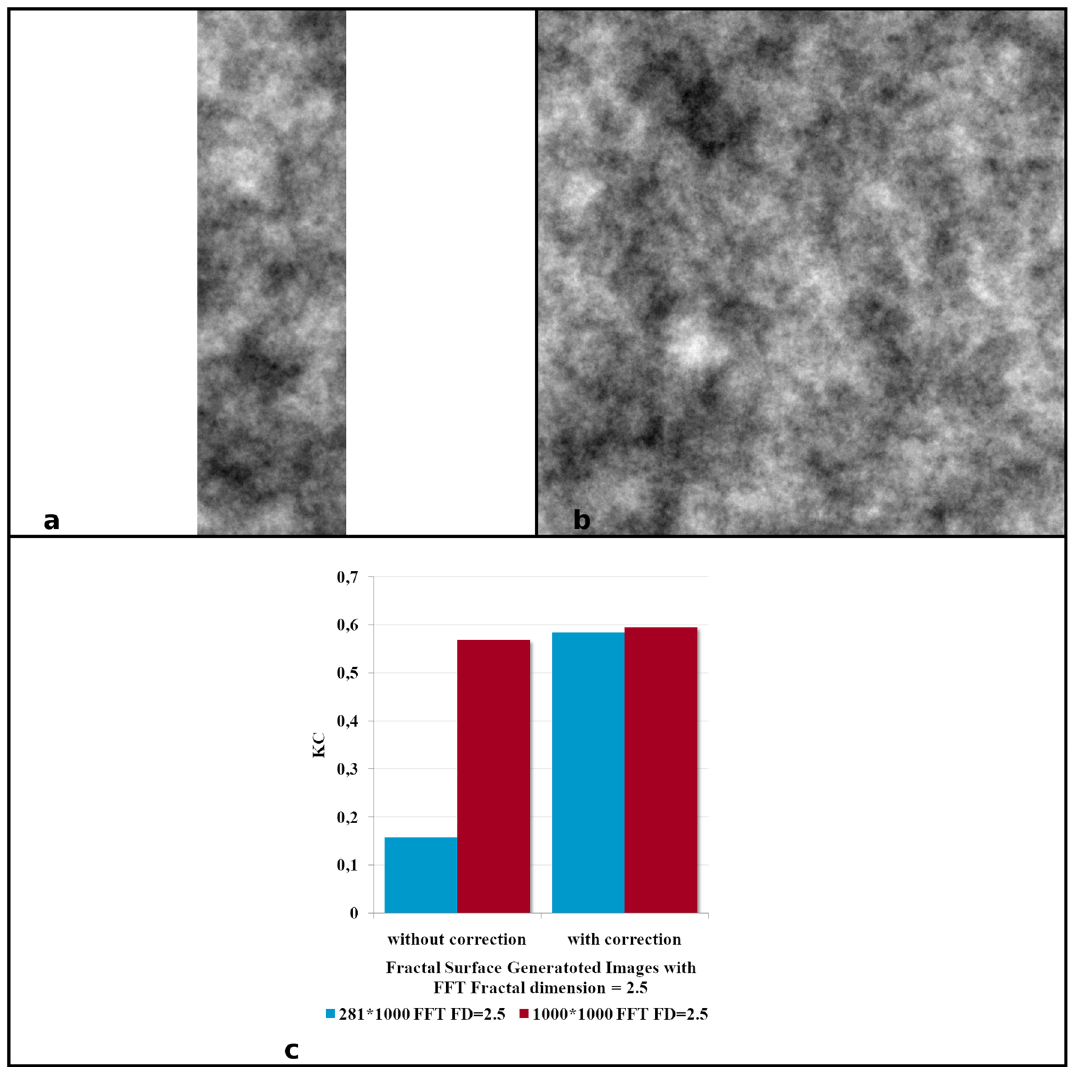
Figure 2. FS images in two resolutions and KC fractal; ( a ) FS images generated with Inverse FTT algorithm and fractal dimension of 2.5 and the lowest resolution of an analyzed icon (281 × 1000) and ( b ) the highest resolution of an analyzed icon (1000 × 1000). ( c ) Each bar corresponds to a single generated image. Although generated images under ( a , b ) have the same fractal dimension, their KC differs greatly due to the difference in size of the two images. Normalization of KC resolves this problem as both images having similar KCs ( b